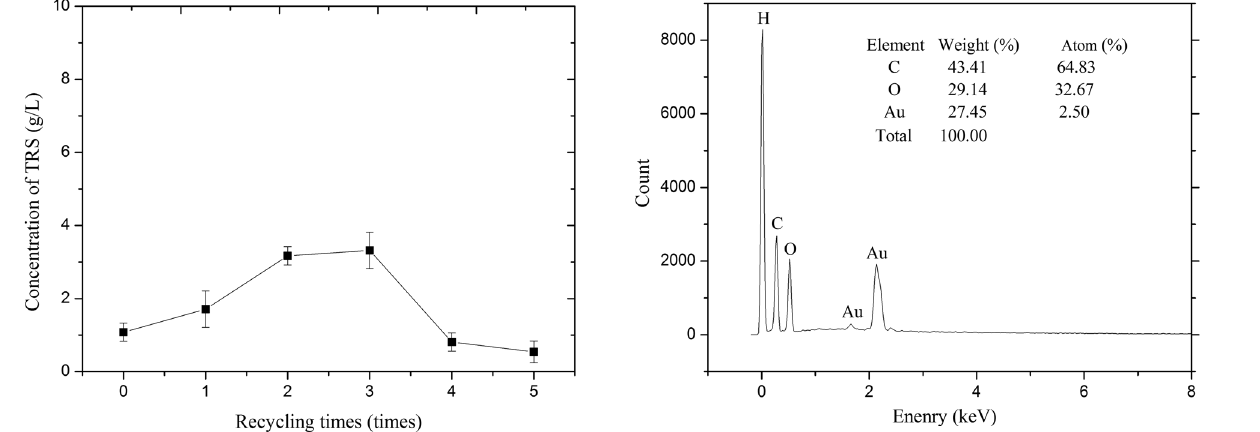
Figure 5: Reducing sugar concentrations in waste liquid after a varied number of cycles.